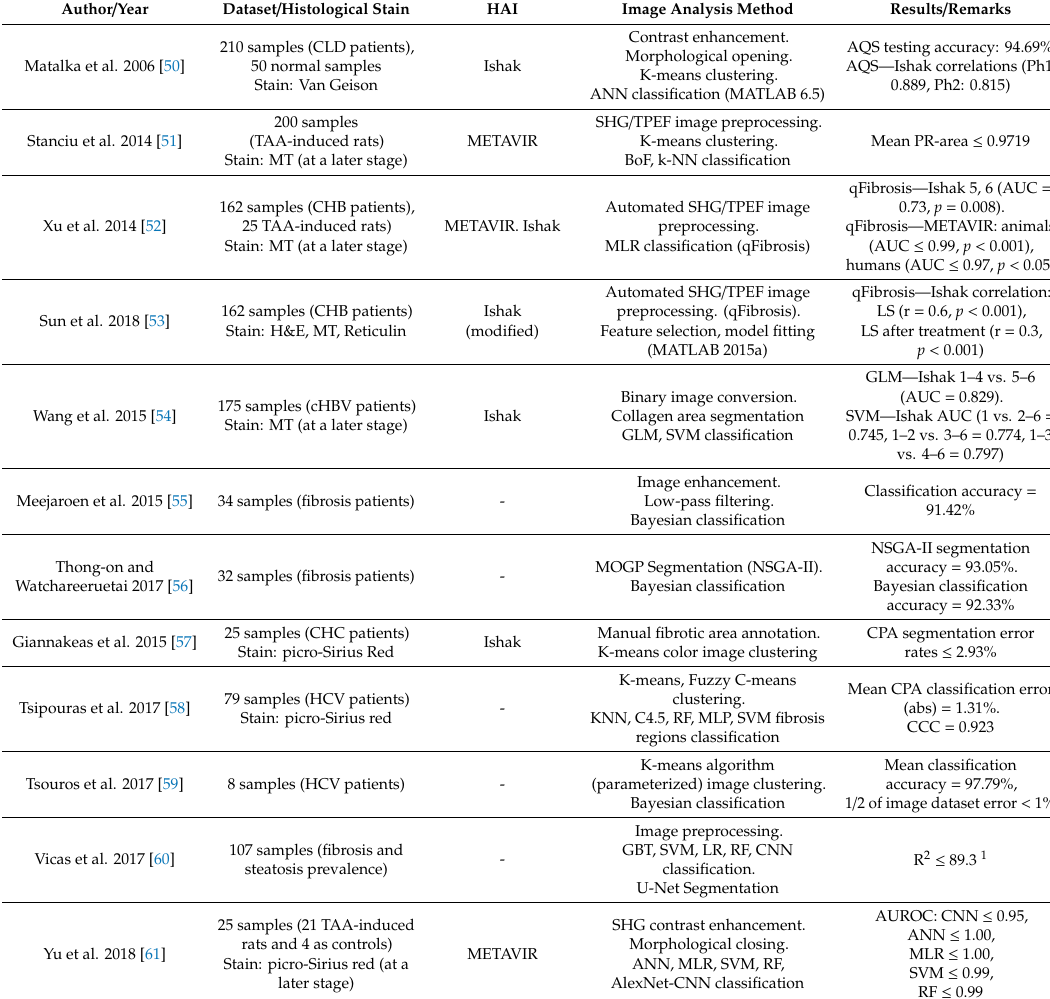
Table 5. Recent publications building intelligent systems for automated CPA